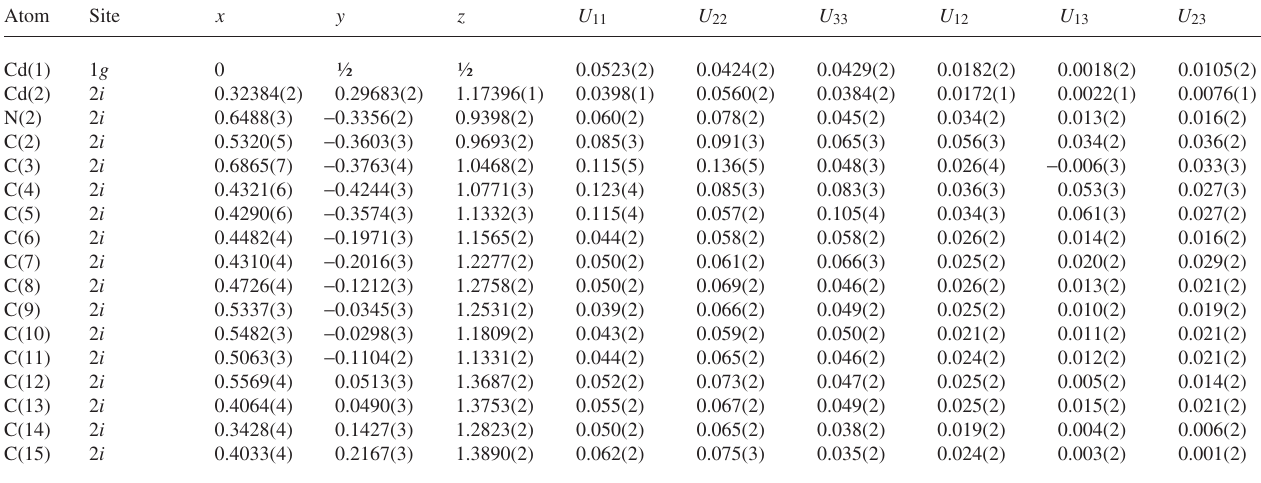
Table 3. Atomic coordinates and displacement parameters (in Å 2 ) .